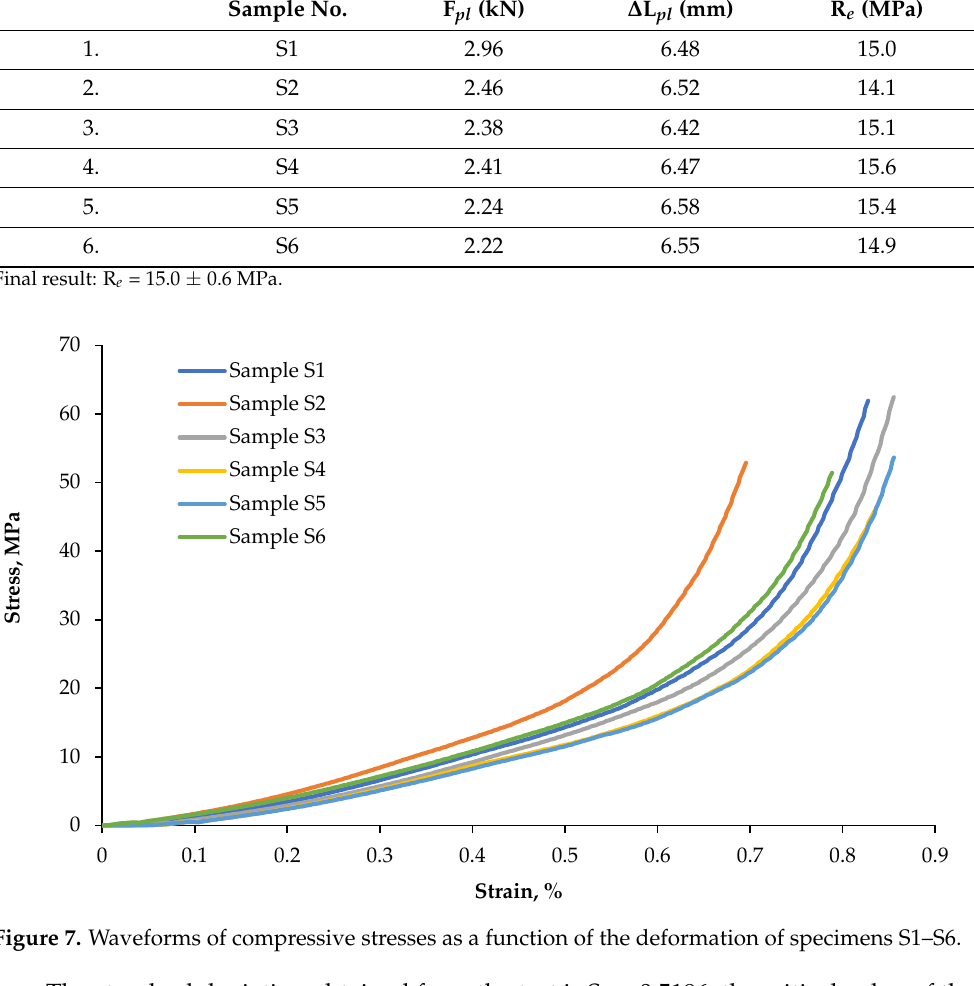
Table 2. The results of the calculation of the plate yield point.